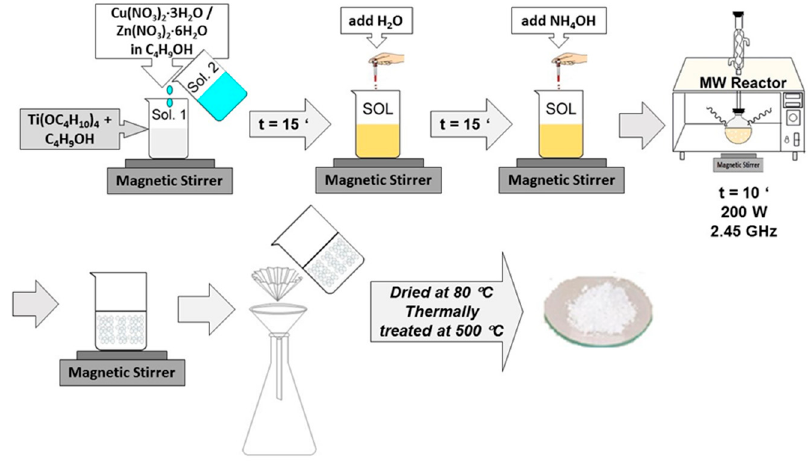
Figure 19. Flowchart of the methodology used for the sample